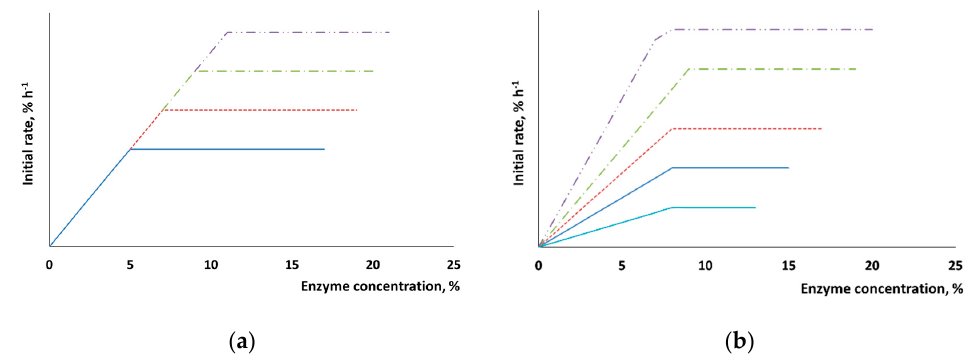
Figure 3. The putative changes in the initial rate of hydrolysis after pretreatment of cellulose ( a ) and the lignocellulosic biomass ( b ).